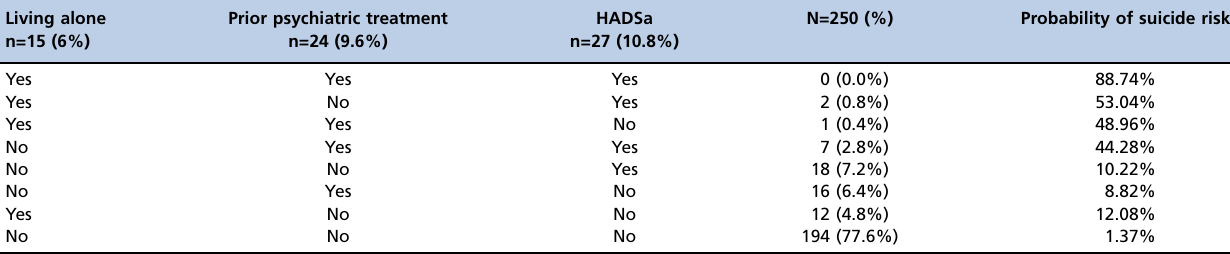
Table 3 - Probability of committing